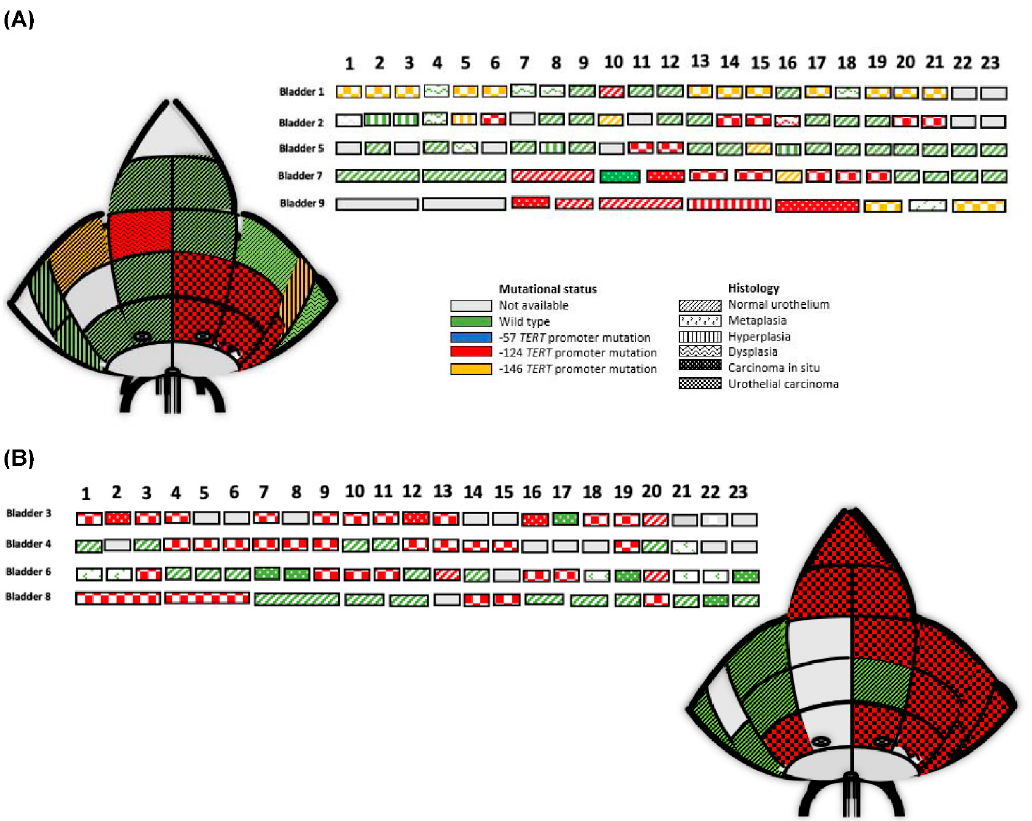
Figure 2. Two representative whole organ mapping bladder schematic diagrams are shown for Bladder 2 (left above) and Bladder 4 (right below), which demonstrate the overall orientation of 23 different tissue histologies, their macroscopic positions as well as the specific TERT promoter mutations. In addition, all nine whole organ mapping bladder specimens (Bladder 1–9) and their respective 23 different tissue histologies, TERT promoter mutational status and indicated tissue macroscopic positions are illustrated as single rectangles in rows. For Bladder 7, 8 and 9 some areas could only be represented as one larger region as illustrated within the figure. ( A ) Five polyclonal bladder cancer specimens demonstrating different tissue histologies as well as the TERT promoter mutational status. ( B ) Four monoclonal whole-organ mapping bladder cancer specimens demonstrate different tissue histologies and TERT promoter mutational status.